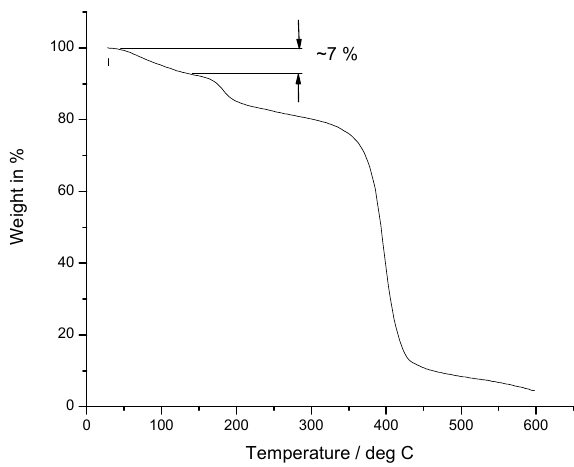
Figure 5. Thermogravimetric analysis (TGA) measurement of amic acid form C2.